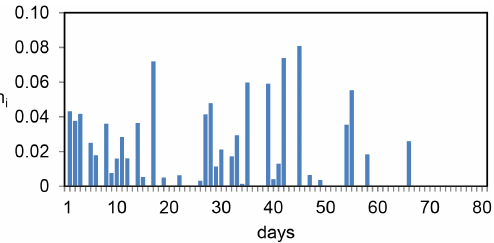
Figure 16. Uncino landslide case study. Kernel providing the best fitness.